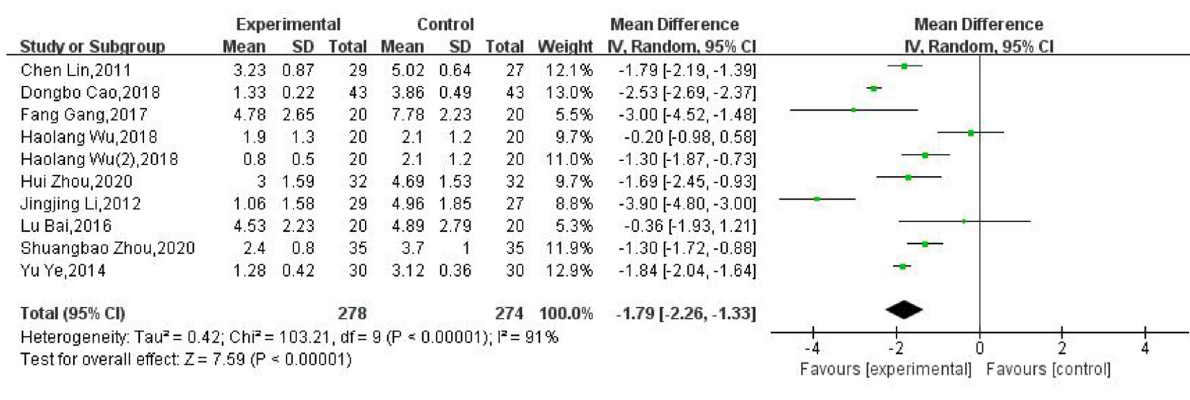
FIGURE 7 | Meta-analysis of VAS data.